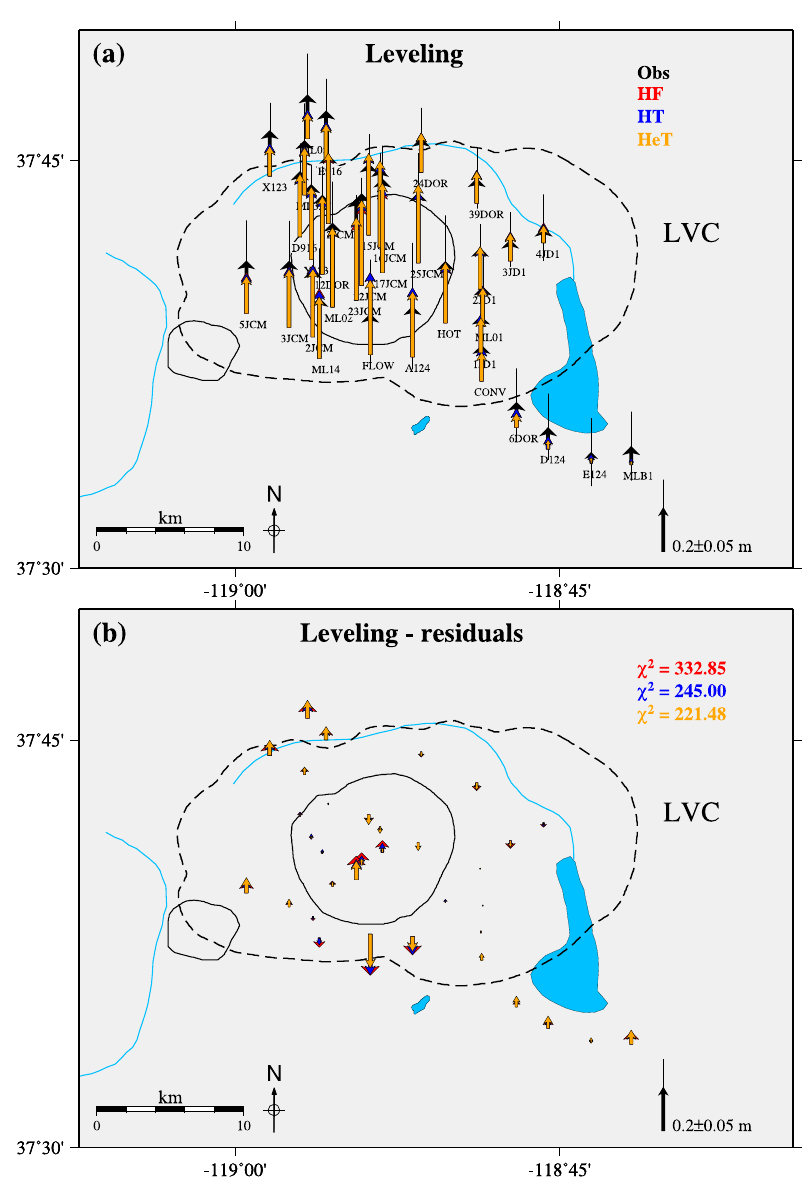
Figure 9. ( a ) Comparison between observed (black arrows with thin solid line as error) and modeled (colored arrows corresponding to different model configurations) uplift for the period 1982–1999. ( b ) Corresponding residuals between modeled and observed uplift. Obs: Observations; HF: homogeneous flat crust; HT: homogeneous crust with topography; HeT: heterogeneous crust with topography. χ 2 values for each model are shown on top right.